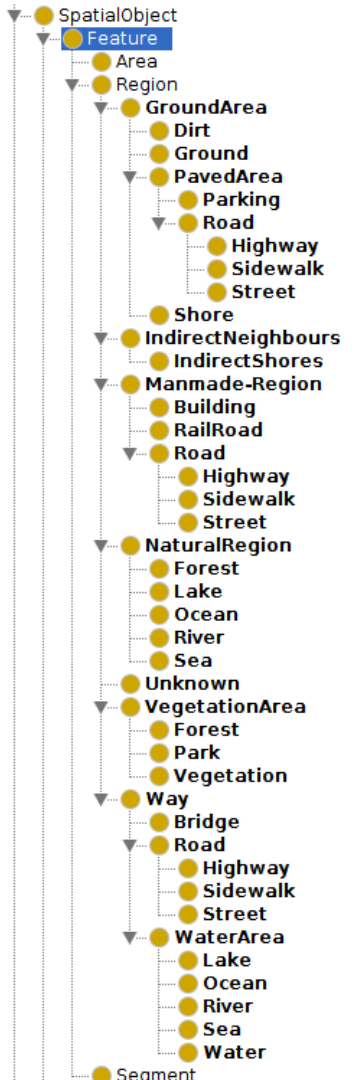
Figure 2. Hierarchy of the subclasses of the class geos:Feature in